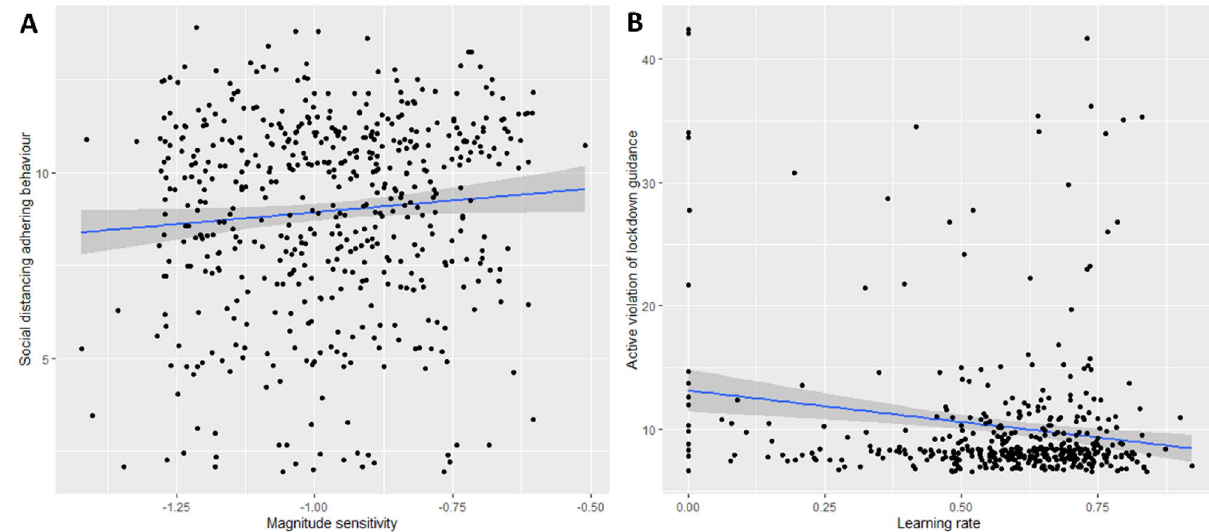
Figure 1. Scatterplots indicating the associations between cognitive and social distancing measures. ( A ) Participants who were more sensitive to reward magnitude (i.e., had lower values on the x-axis) reported lower levels of social distancing adherence (i.e., had lower values on the y-axis). ( B ) Participants who had a lower learning rate (i.e., had lower values on the x-axis) reported higher levels of active violation of lockdown policies (i.e., had higher values on the y-axis). Regression lines are highlighted in